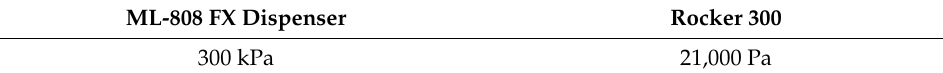
Table 2. Experimental parameters of air jet pressure.